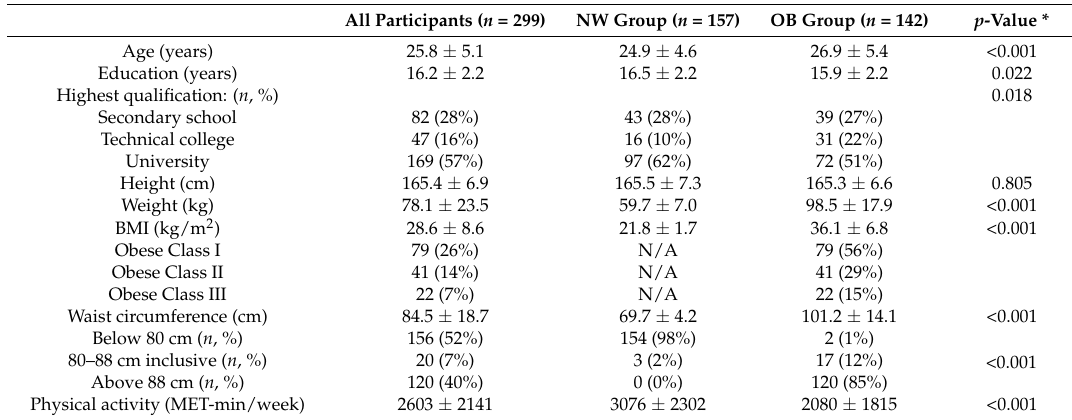
Table 1. Demographic characteristics of